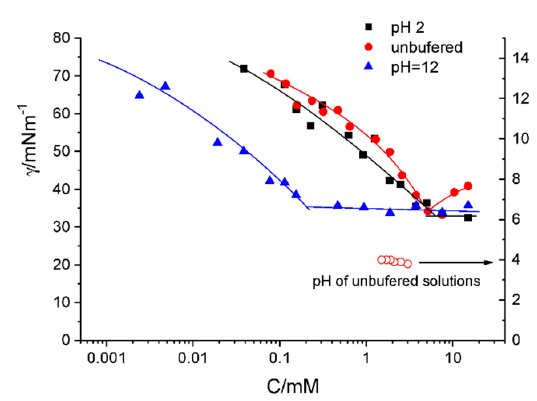
Figure 2. Surface tension as a function of concentration for histidine surfactant (DMHNHC 14 ) in three different pH conditions at 25 °C.